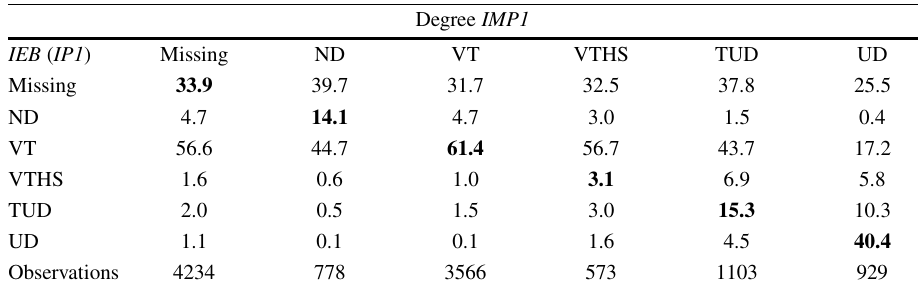
Table 10 Cross tabulation of IMP1 vs. IEB , I